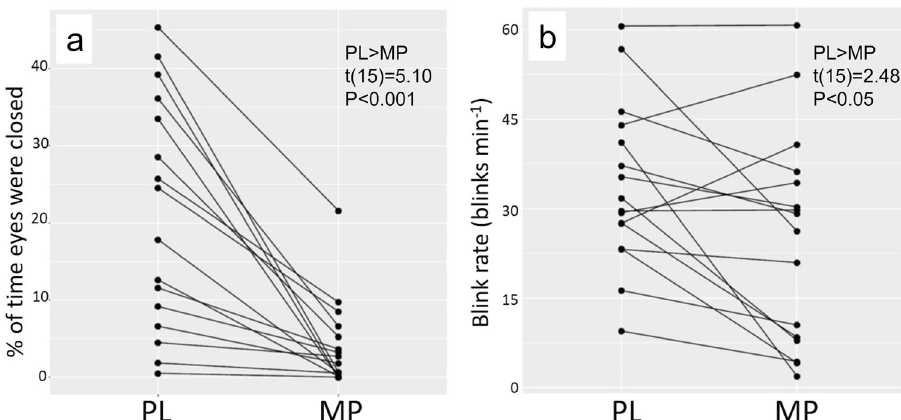
Fig. 1 Measures of eye behavior collected via eye-tracker. Measures of eye closures a and blink rates b after placebo (PL) and after methylphenidate MP. MP signi fi cantly reduced eye closures as well as